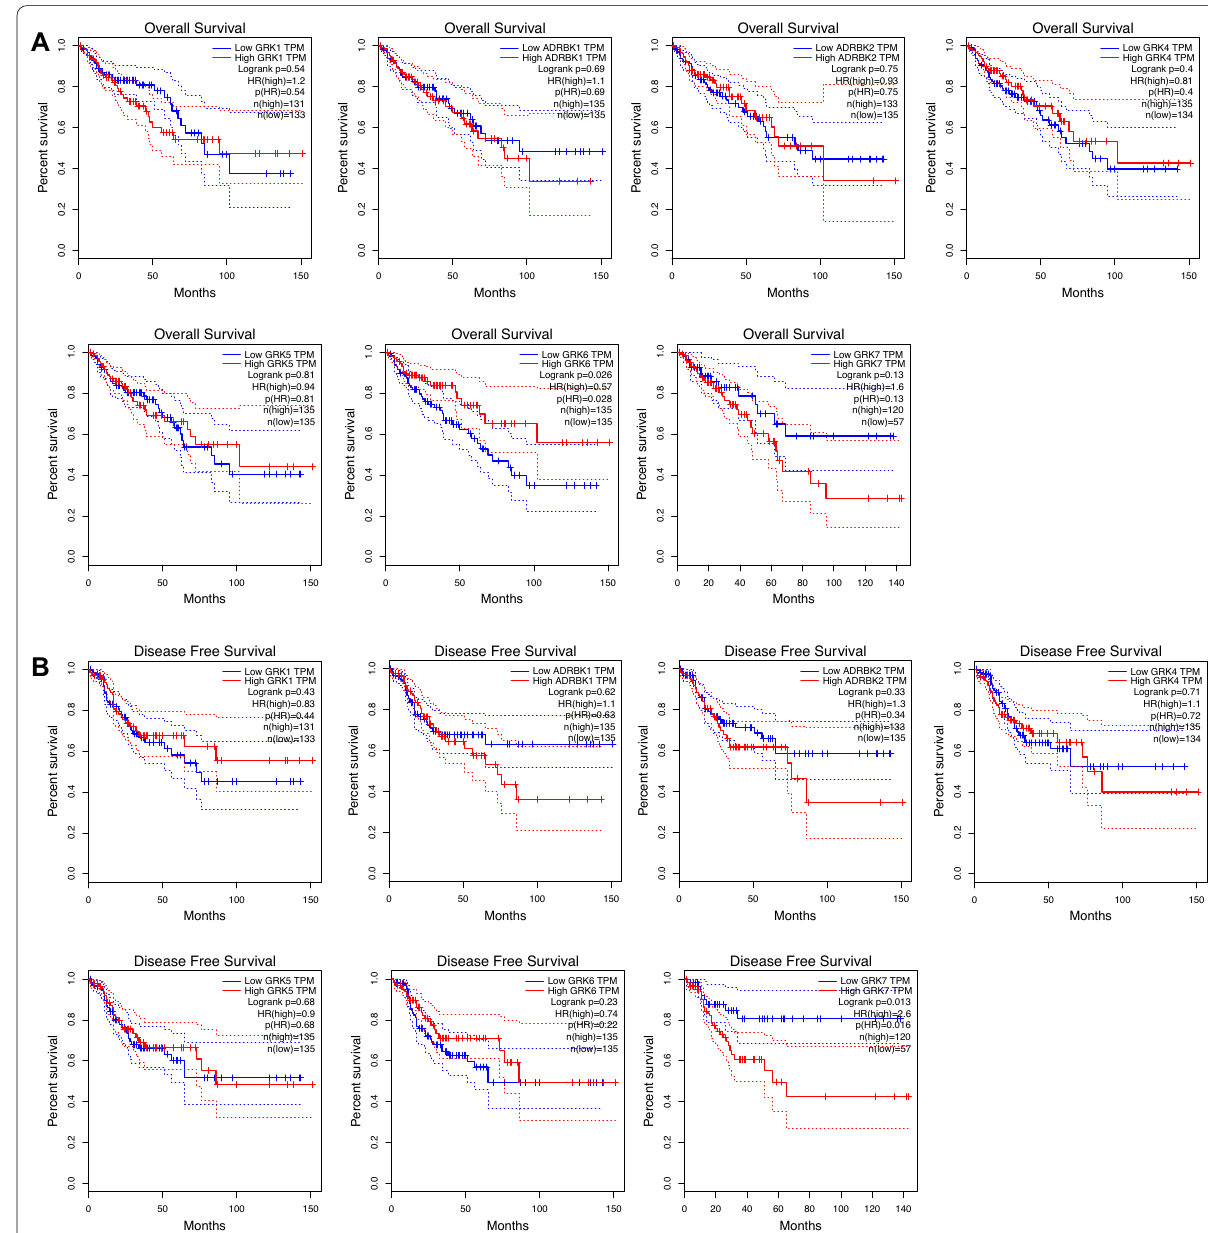
Fig. 4 KM Plotter related to mRNA expression of GRK family based on ( A ). Overall survival and ( B ). disease-free survival as analyzed by GEPIA. C Prognostic value related to the mRNA expression of GRK family as analyzed by